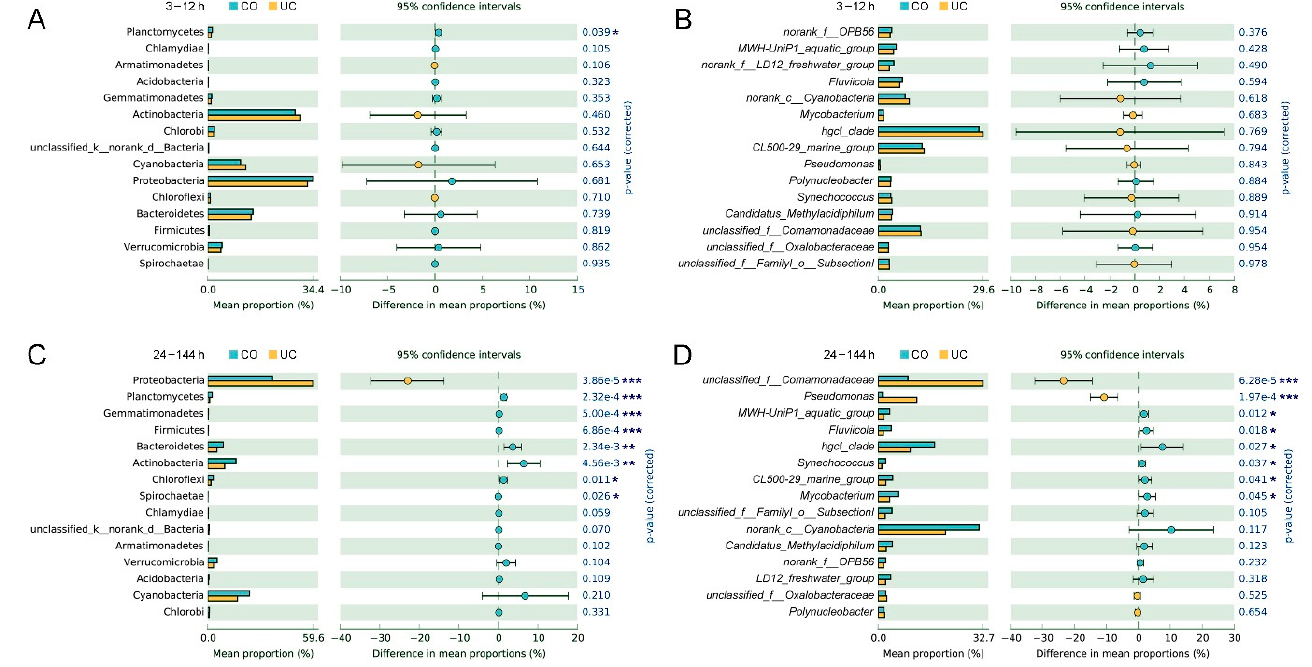
Figure 2. Significant differences of relative abundances of the top 15 prokaryotic phyla ( A , C ) and genera ( B , D ) between CO (with lid closed) and UC (without lid) groups. Shown are the averages from n = 3. *: 0.01 < p ≤ 0.05, **: 0.001 < p ≤ 0.01, ***: p ≤ 0.001.